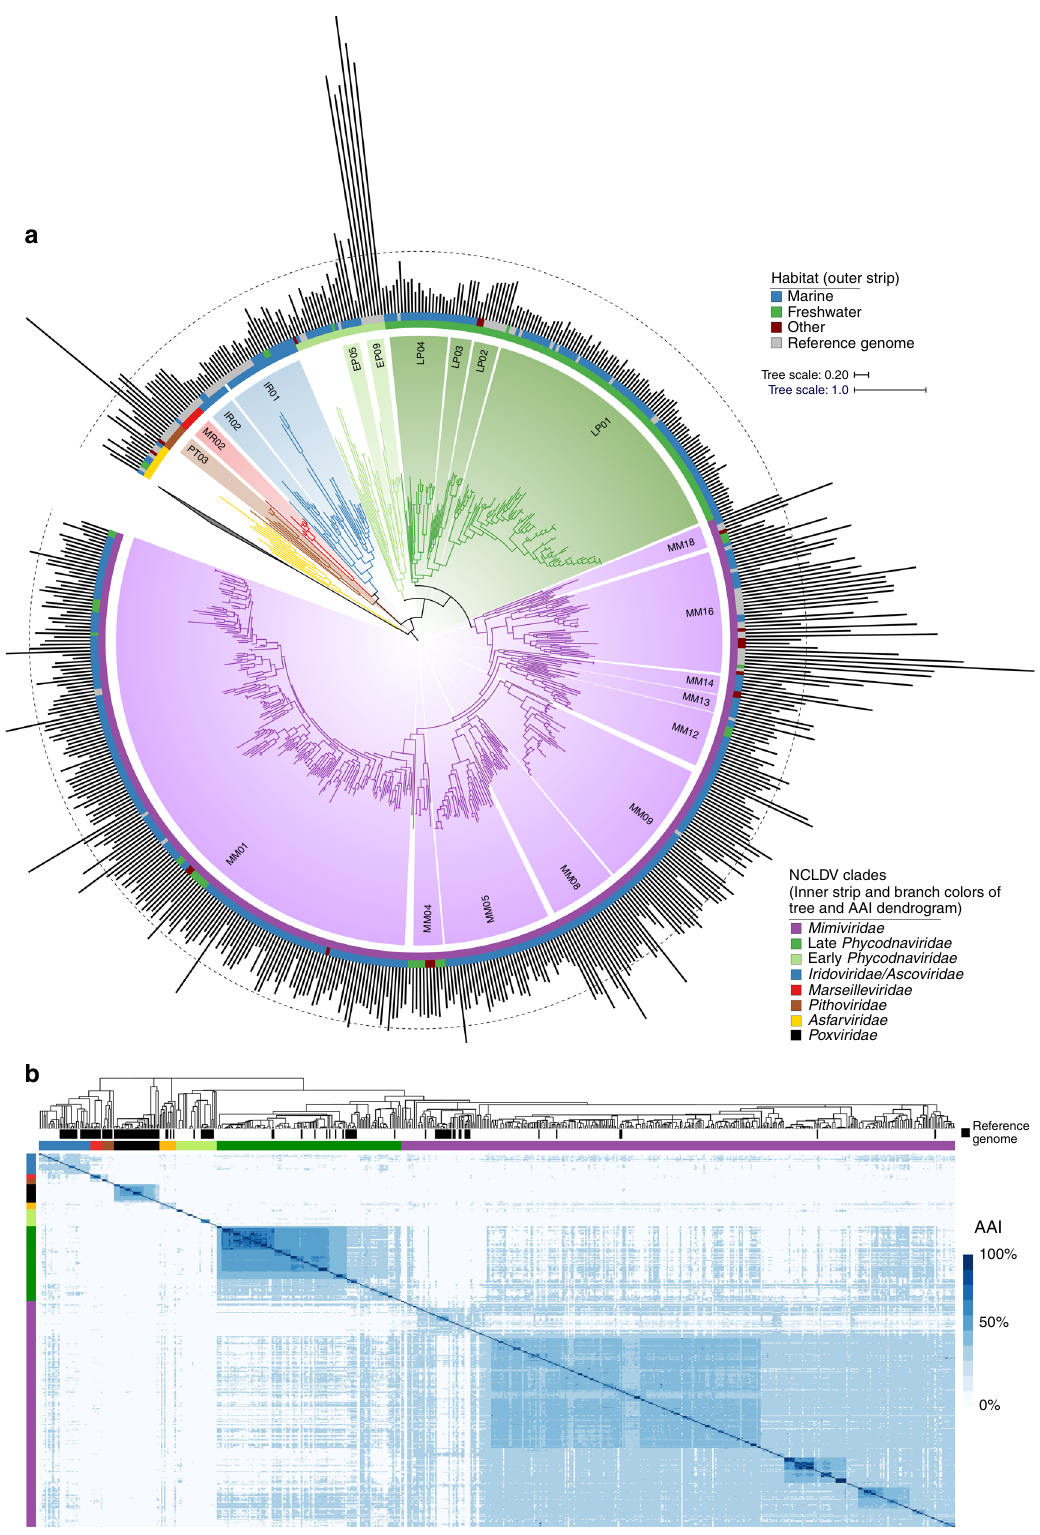
Tree scale: 0.20 Tree scale: